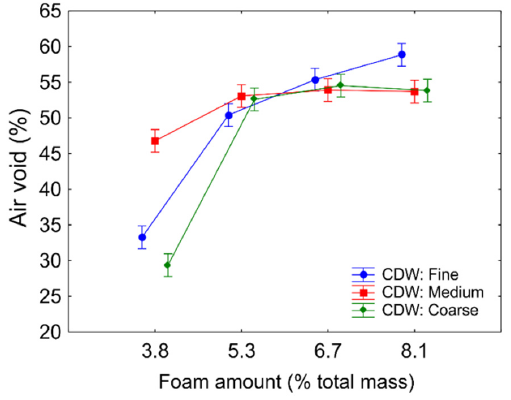
Figure 7. AV as a function of FA for different CDW granulometries.